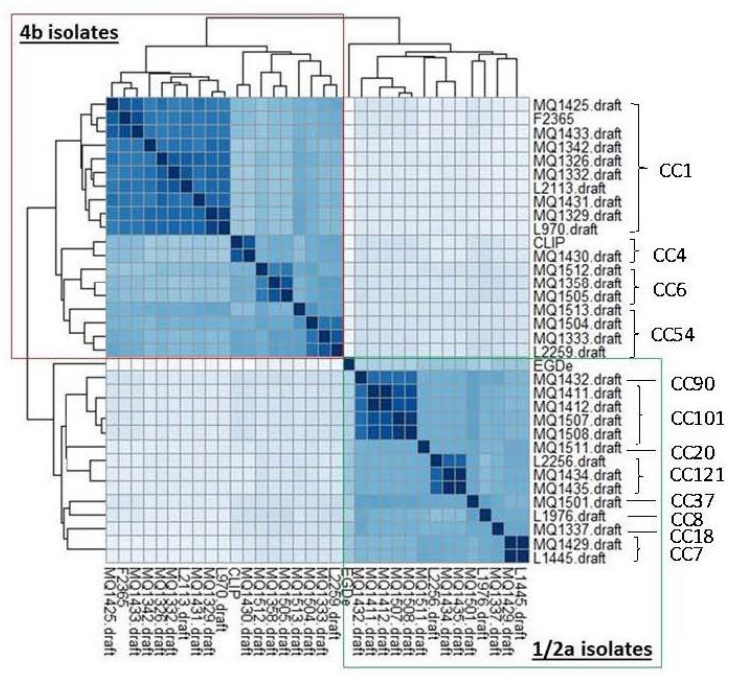
Figure 4. The presence and absence of genes can be used to cluster the isolates into serotypes and sequence types.